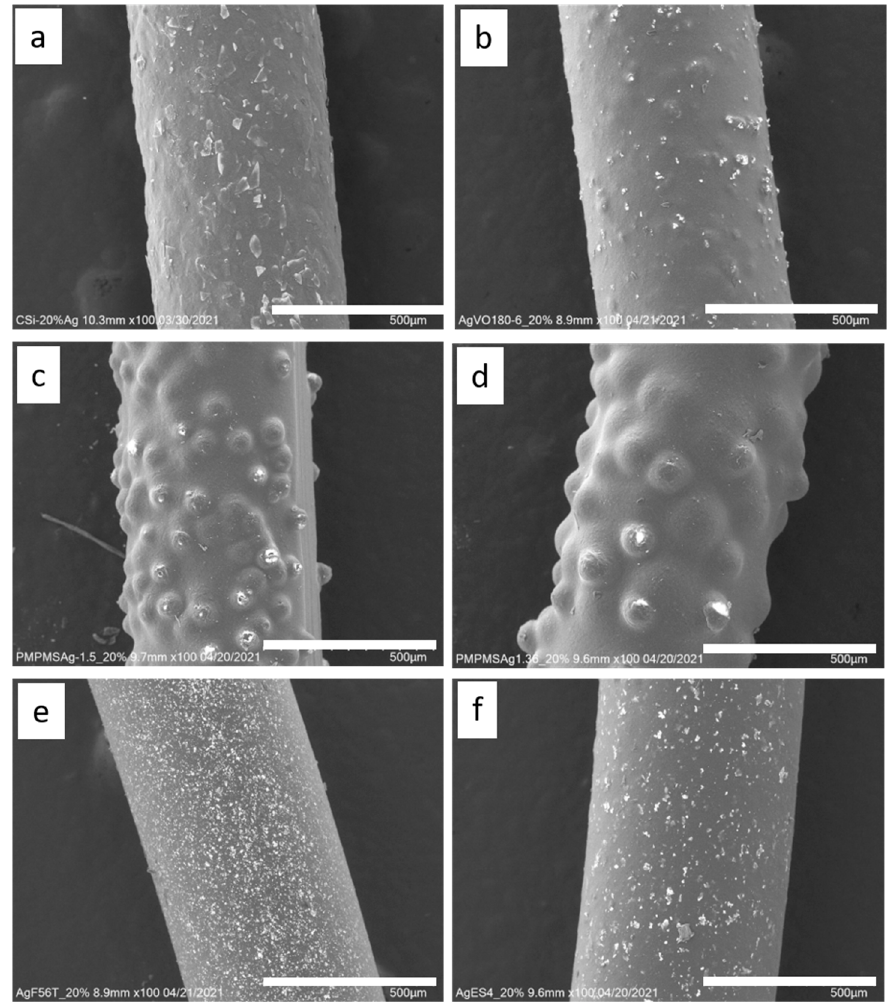
Figure 2. SEM images of coated monofilaments each with 20% silver addition. ( a ) Ag352000, ( b ) AgVO180-4, ( c ) Ag1.53, ( d ) Ag1.36, ( e ) Ag F56T, ( f ) AgES4. Size bar = 500 µm.